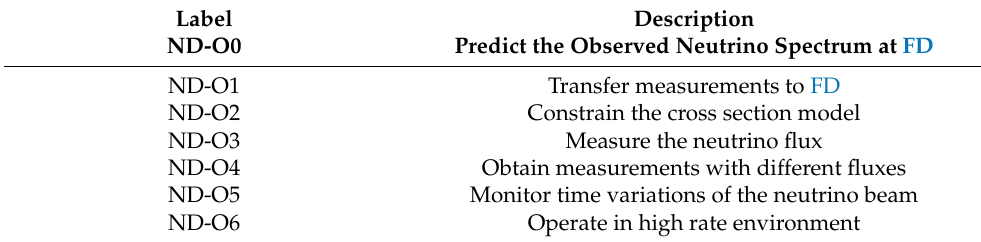
Table 2. Overarching requirements for